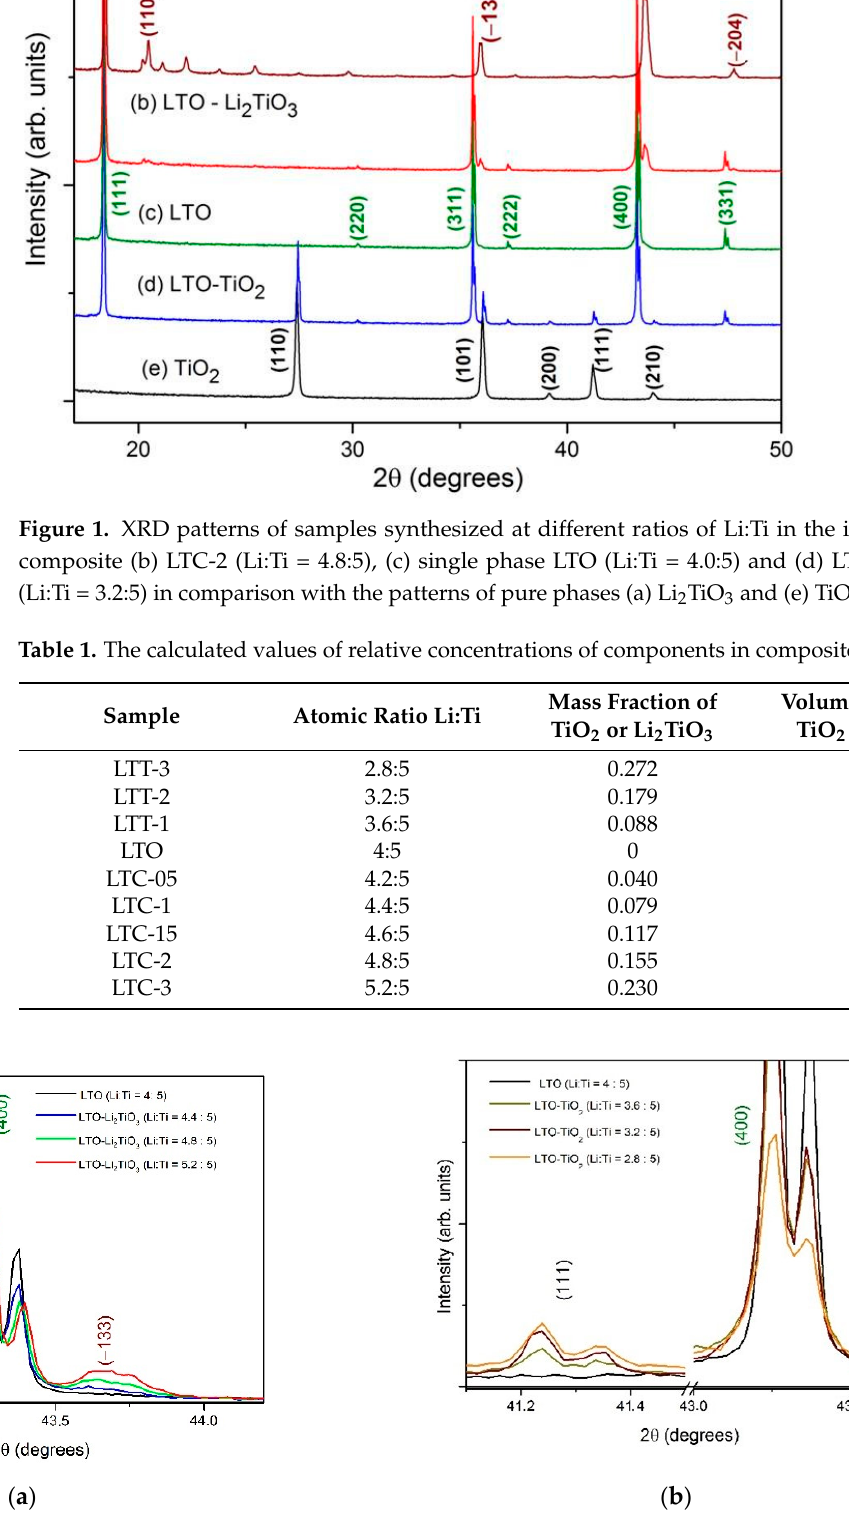
Figure 2. The sections of XRD patterns showing both the reflections of LTO and the impurity phase in the pure LTO sample and ( a ) in LTC-1, LTC-2, LTC-3 and ( b ) LTT-1, LTT-2, LTT-3 composites.